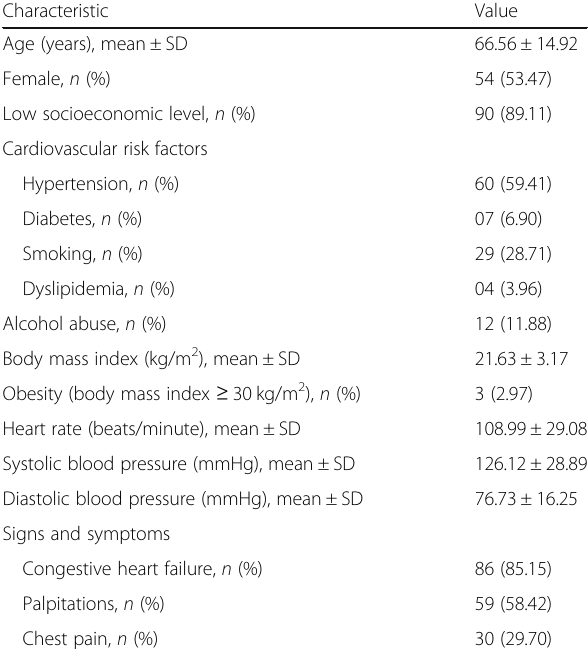
Table 2 Laboratory baseline findings and underlying heart diseases of the study